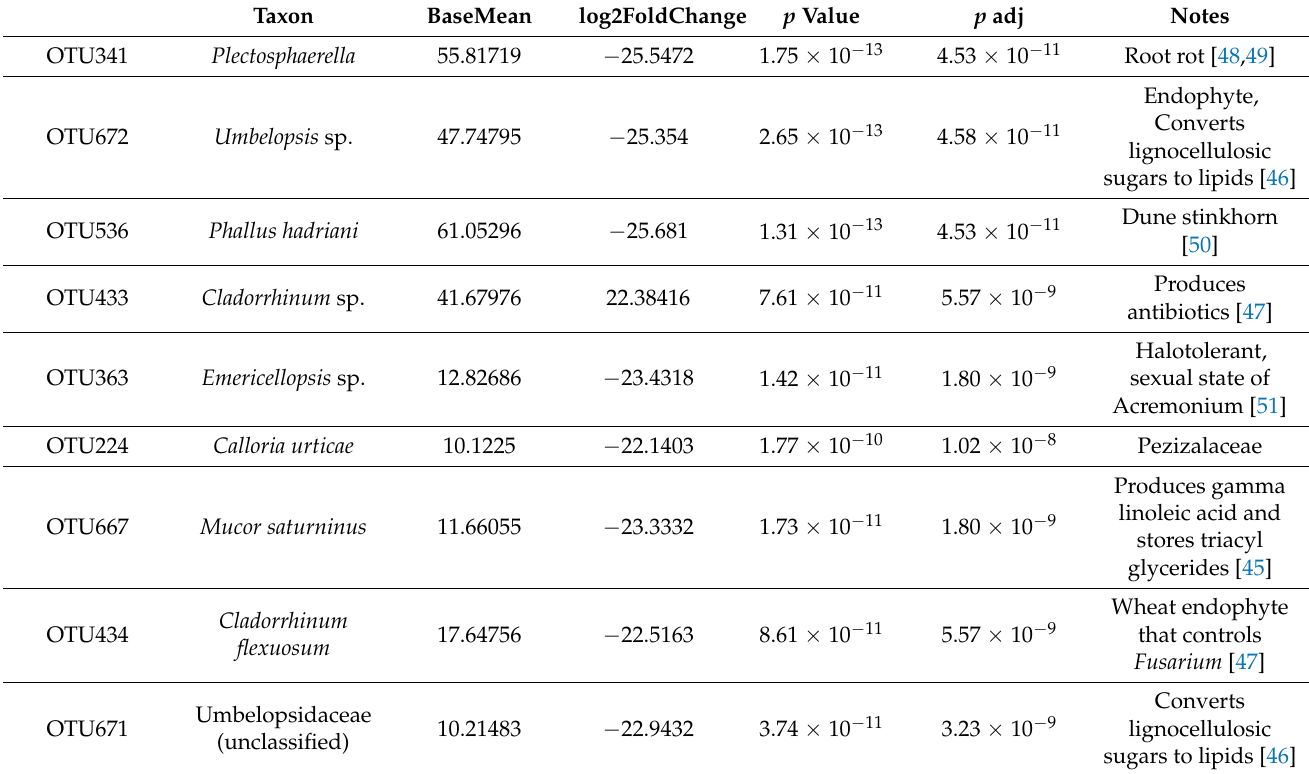
Table 6. DESeq results for differentially expressed fungal taxa associated with the Green Trail vs. the Blue Trail (Round 1). Positive fold change values correspond to sequences that were differentially abundant on the Green Trail; taxa with significant negative fold change values are associated with the Blue